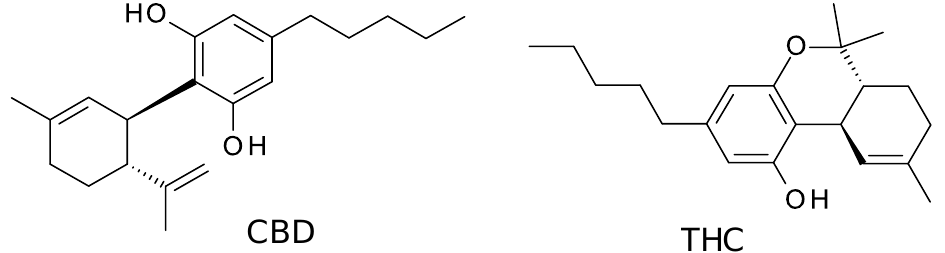
Figure 2 Chemical structures of CBD (2-[(1 R ,6 R )-3-methyl-6-prop-1-en-2-ylcyclohex-2-en-1-yl]-5-pentylbenzene-1,3-diol) and THC ((6a R ,10a R )-6,6,9-trimethyl-3-pentyl-6a,7,8,10a-tetrahydro-benzo[c]chromen-1-ol).